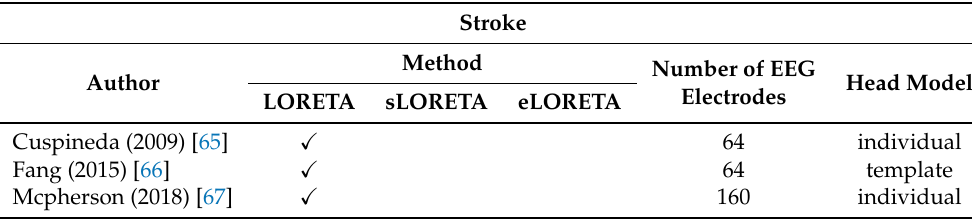
Table 5. Overview of the included papers about